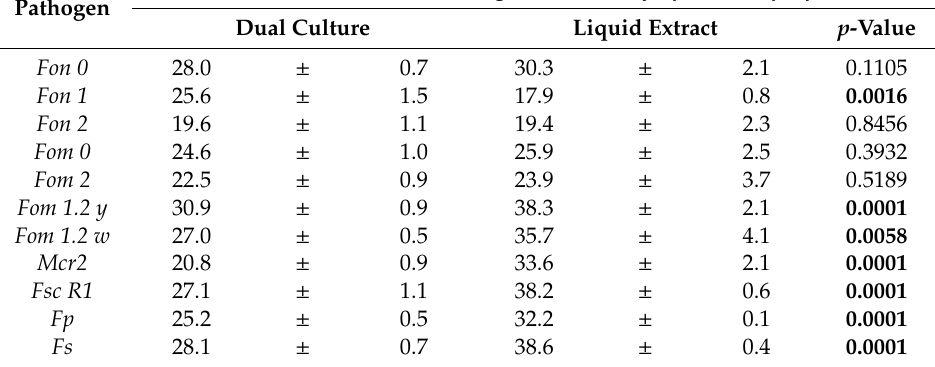
Table 6. Comparison of radial growth (mean value ± SD) between dual culture and secondary metabolites extract inhibition assays with E. purpurascens